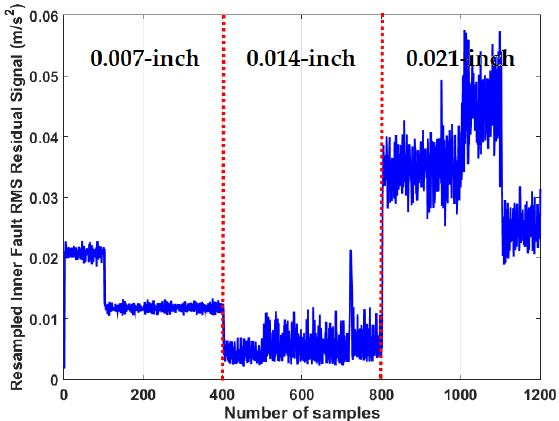
Figure 14. The RMS resampled inner fault residual signal using the proposed ADT algorithm for crack size identification.